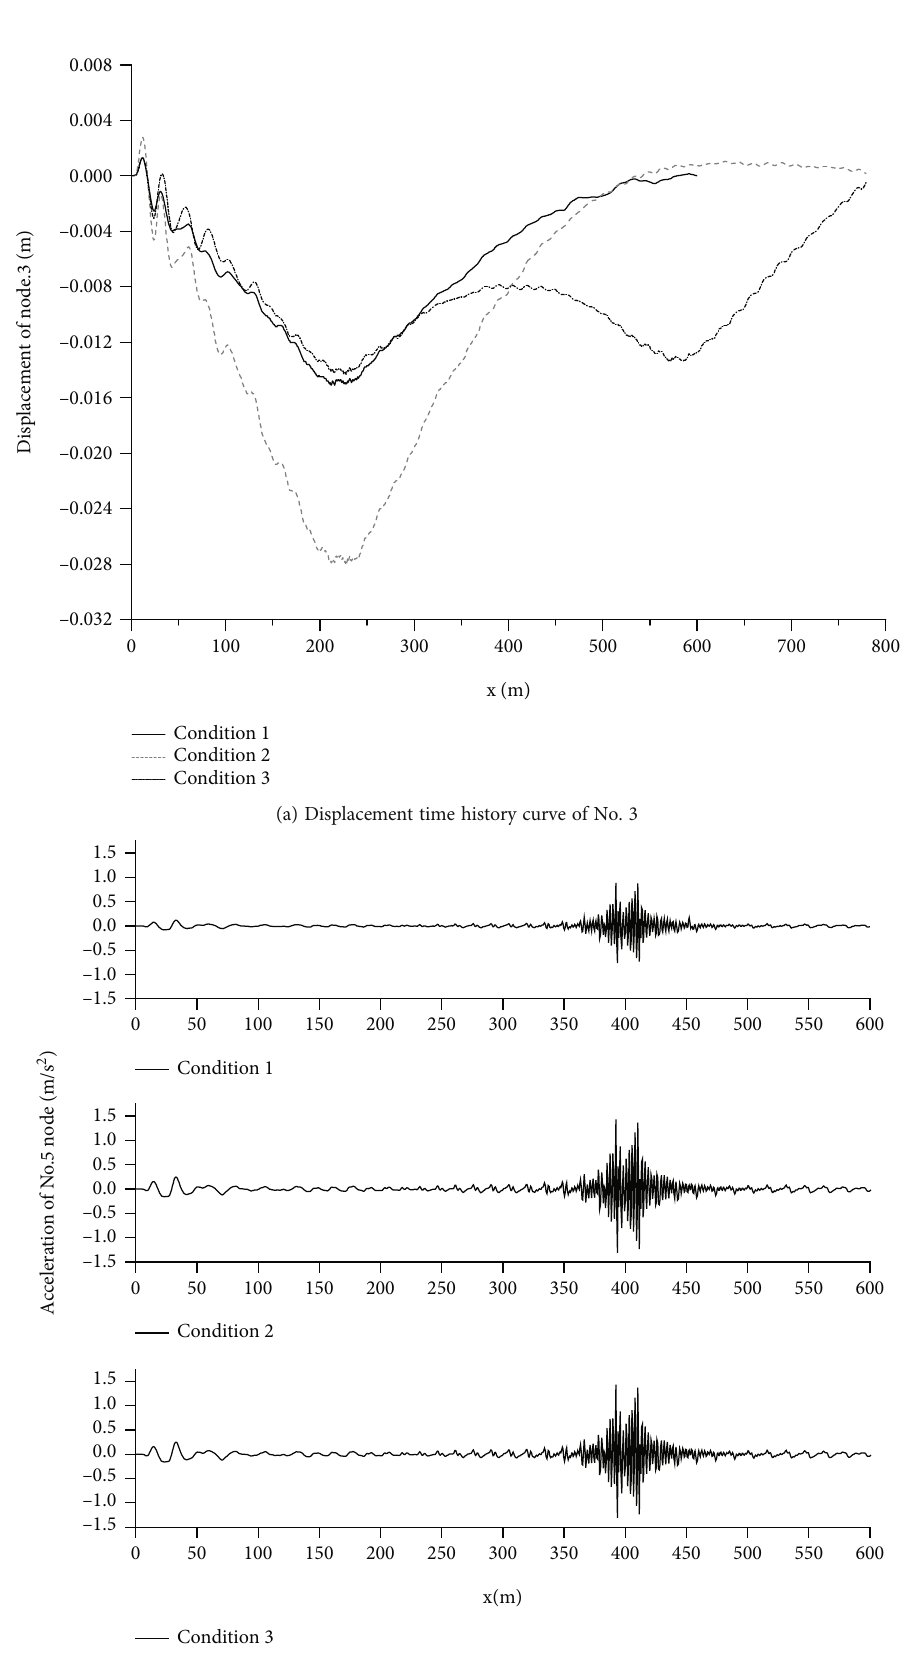
(b) Node 5-point acceleration time history curve under di ff erent working